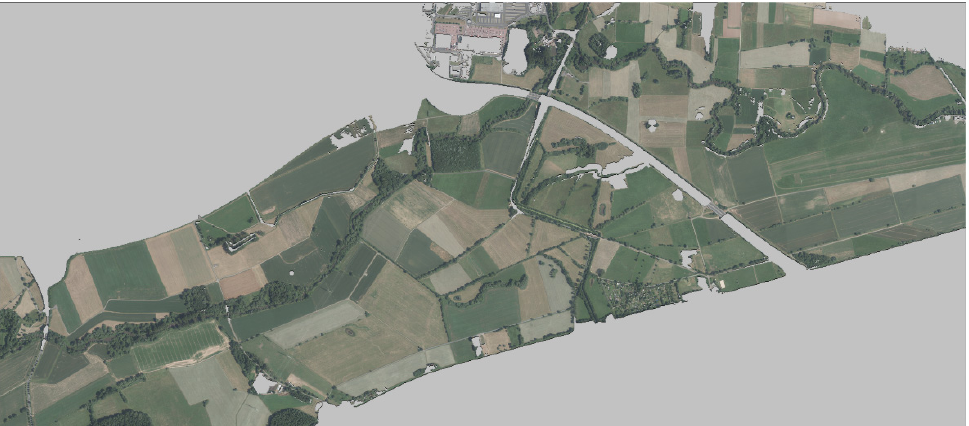
Figure 8. Image of the model area of the Kinzig floodplain. The dam that divides the image in the right side is a highway connection. The Kinzig flows from right to left in the figure. Land use is mostly farming. Higher vegetation occurs along the river course.